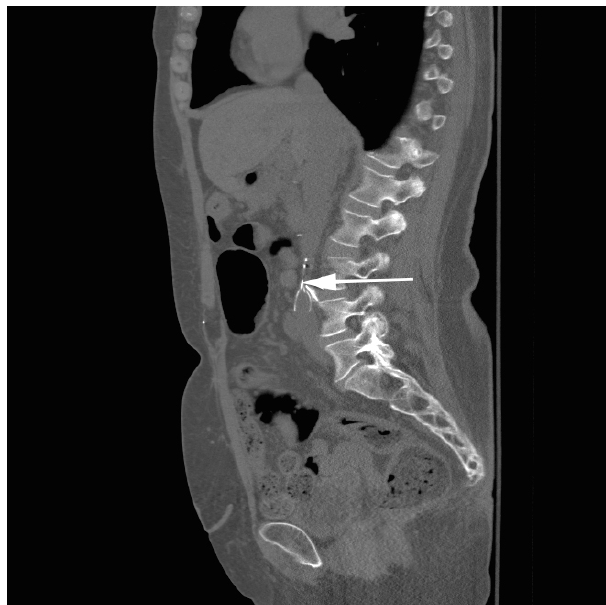
Figure 2. Sagittal computed tomography view of lumbosacral spine. Arrowhead demonstrates fracture and displacement of the posterolateral inferior vena cava filter